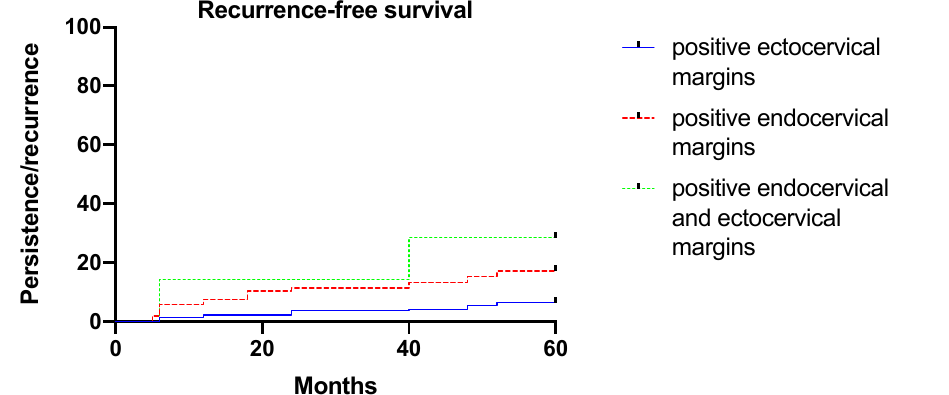
Figure 2. Five-year recurrence-free survival according to margin status.